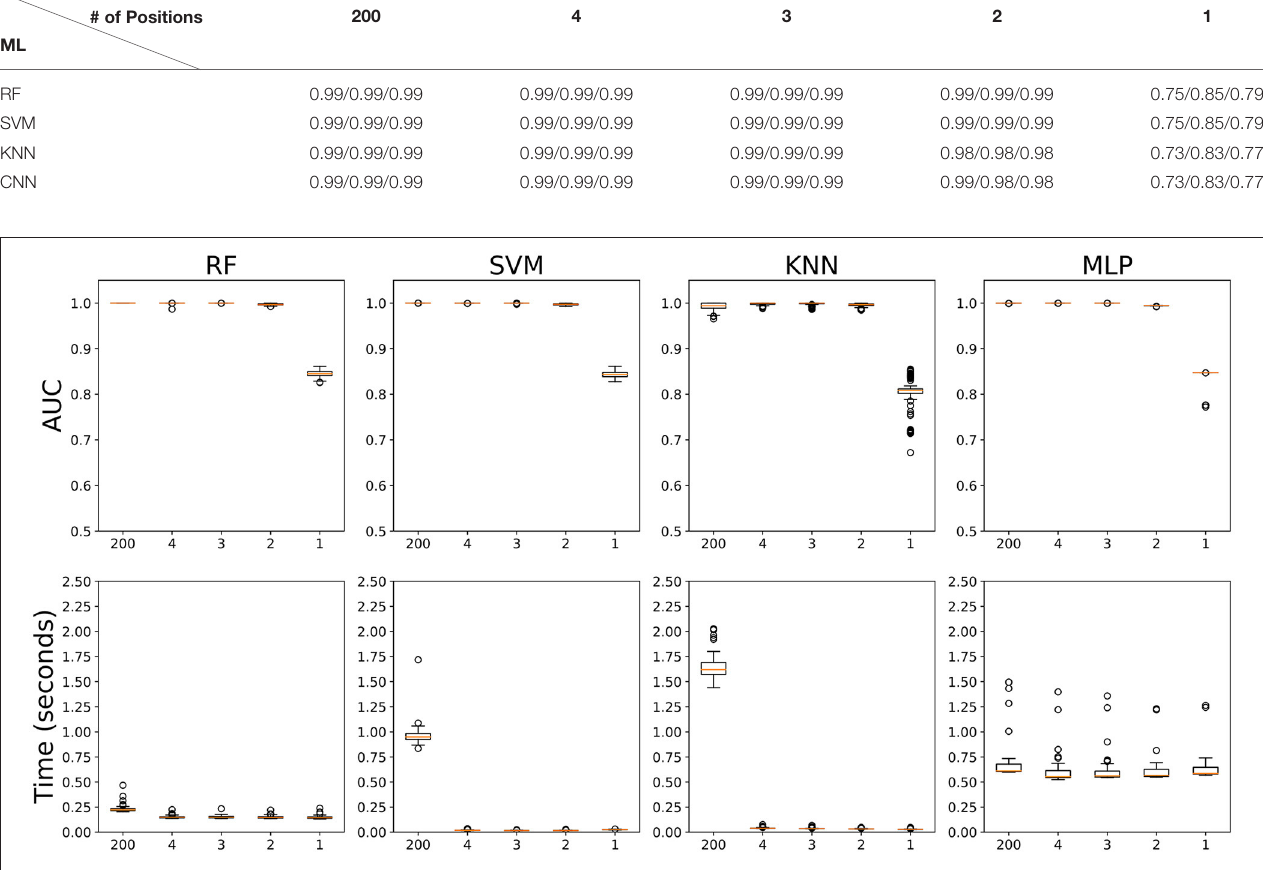
at a pig farm level (e.g., Prevacent R (cid:13) for lineage 1 and